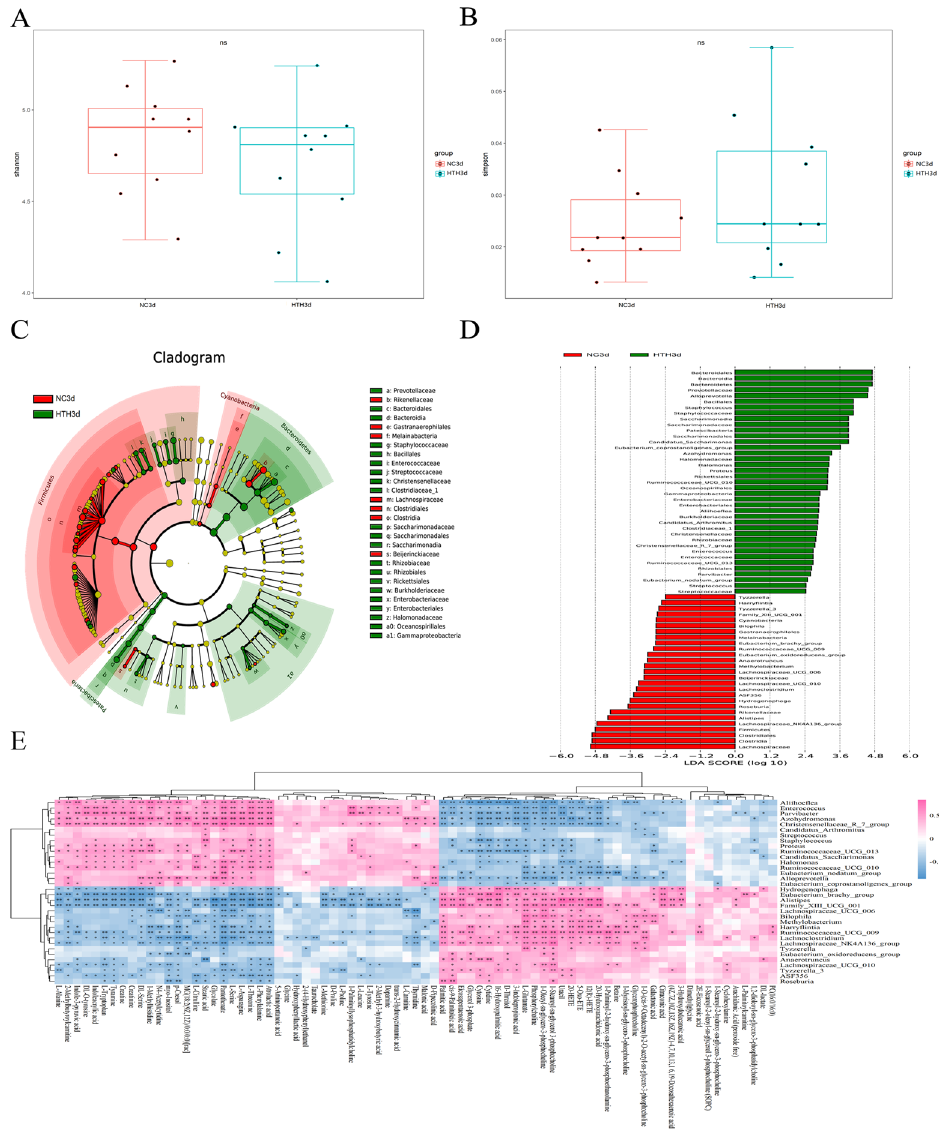
Figure 3. Alpha diversity of bacterial communities. Use box plots to visualize estimates of bacterial diversity ( A and B ). The boxplot shows the median, quartile, minimum, and maximum observations. Wilcoxon rank-sum test was performed to determine the statistical significance of the alpha diversity analysis. ( C and D ) LEFSe analysis of intestinal flora. The branch chart shows the differences in the fecal taxa. The letters correspond to taxonomic units with rich differences. The red node indicates the microbial group that plays an important role in the red group, the green node indicates the microbial group that plays an important role in the green group, and the yellow node indicates the microbial group that does not play an important role in both groups. The histogram represents the significant difference in abundance of LDA scores between bacteria (LDA > 2) compared groups, expressed in different colors. The taxa are displayed (LDA > 2). LEFSe: linear discriminant effect size; LDA: linear discriminant score. ( E ) The relationship between different triggering bacteria and plasma metabolites in different groups was expressed by a heat map, r > 0.5. r > 0 means positive correlation, expressed in red; r < 0 means negative correlation, expressed in blue. The darker the color, the stronger the correlation. p Value reflects the significant level of correlation, 0.01 < p value < 0.05, expressed by *, p value < 0.01, expressed by